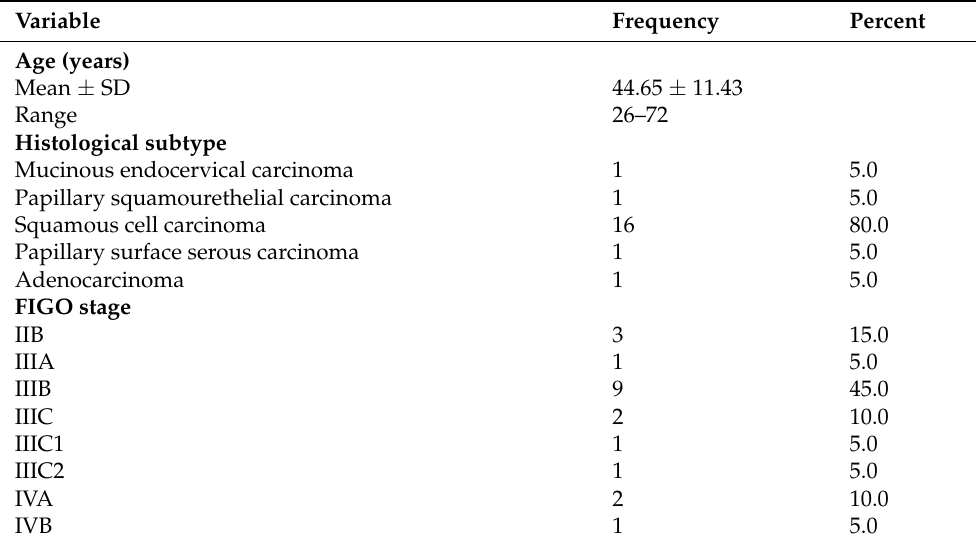
Table 1. Demographic characteristics of the patient